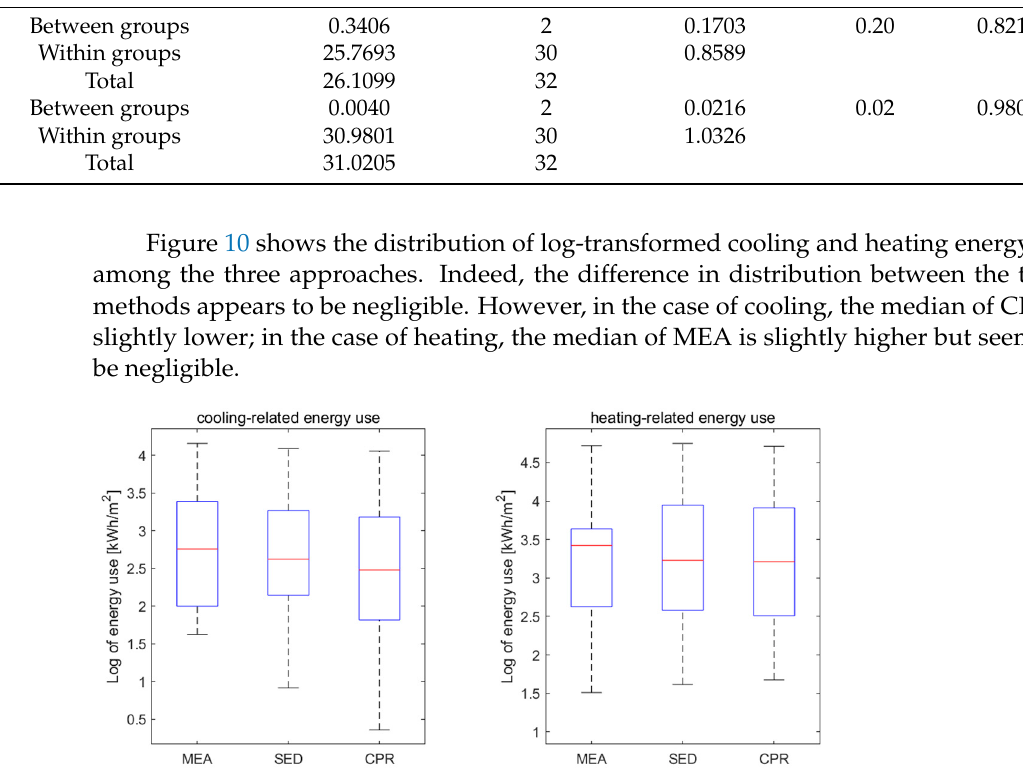
Figure 10. Distribution of log of estimates (SED, CPR) and measurement (MEA).